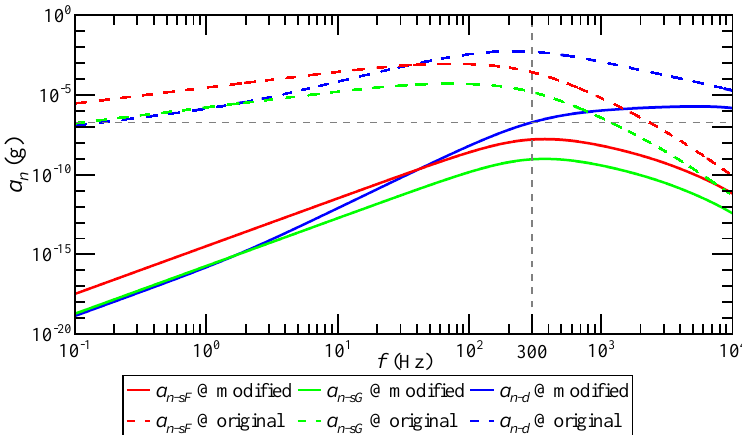
Figure 17. Before and after detection-circuit optimization, the relationship between the magnitude of 𝑎 𝑛 and the frequency of 𝑎 𝑖 under 1 g input acceleration. The system inputs a random acceleration of 0~10 g and a frequency of 0~300 Hz; the equivalent acceleration of detected noise after optimization is shown in Figure 18. The mean of 𝑎 𝑛−𝑠𝐹 is 1.19 × 10 − 3 μg, 𝑎 𝑛−𝑠𝐺 is 2.47 × 10 − 5 μg, and 𝑎 𝑛−𝑑 is 8.47 × 10 − 3 μg.